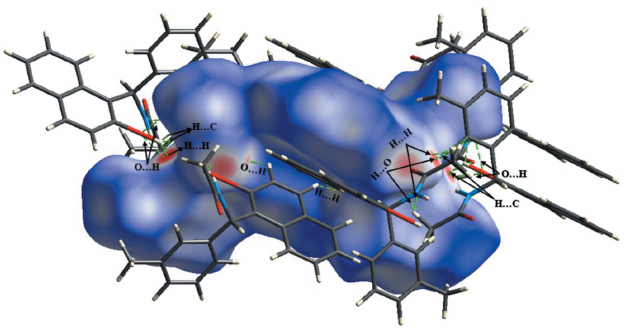
Figure 4 A view of the Hirshfeld surface mapped over d norm , with neighbouring interactions shown as green dashed lines.